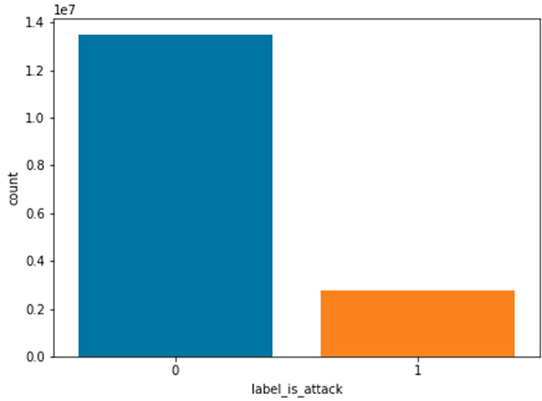
Figure 4. Number of benign and malicious flows.